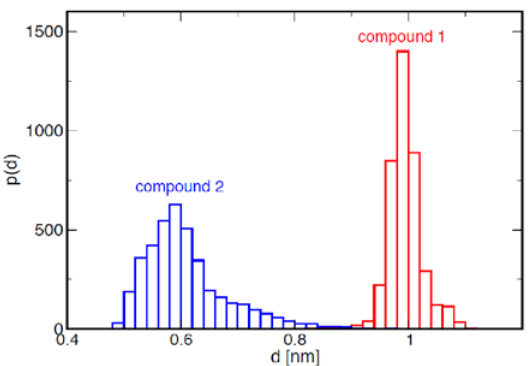
Figure 4. Distribution of distances d between the centers of mass of Neu5Ac and GlcNAc for compounds 1 and 2 , respectively.